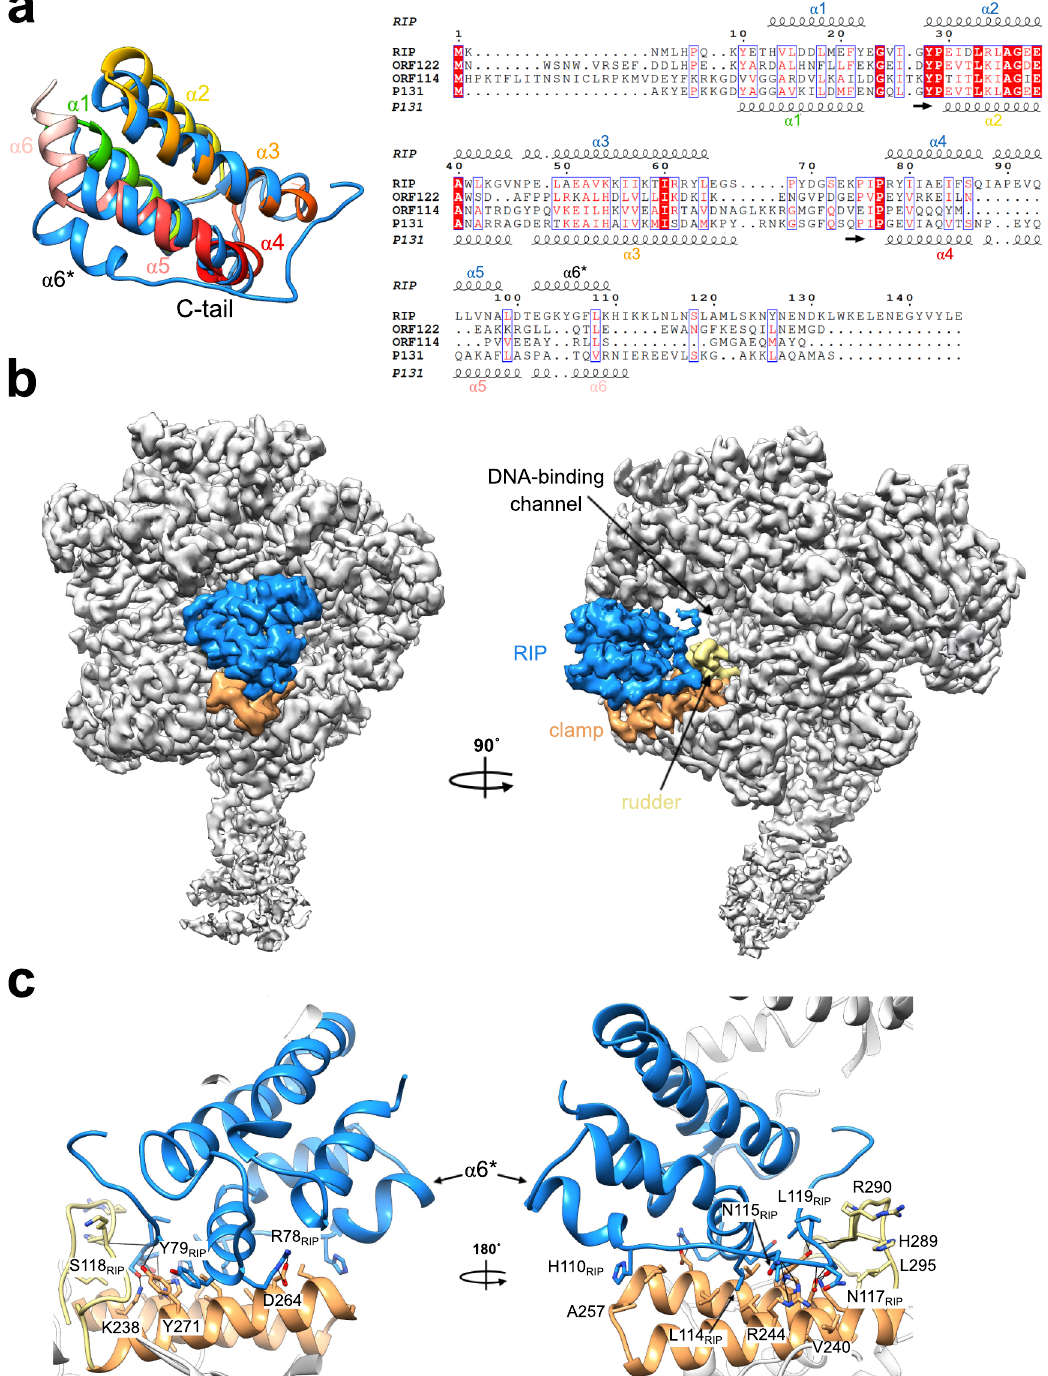
Fig. 2 RIP forms a plug on top of the DNA binding channel of RNAP. a Structure superimposition of RIP and its viral relative ORF131/P131 (pdb code 3faj). RIP is shown in blue and ORF131/P131 in a gradient of colours from the N-terminus in green to C-terminus in light pink with the helix numbering indicated. The orientation of the RIP α 6 helix (indicated with an asterisk) diverges from P131. The corresponding multiple sequence alignment with viral proteins closely related to RIP was performed in PROMALS3D. They include SMV-1 ORF122 and ORF114, as well as the ATV P131 (ORF131). The secondary structure annotation generated by Espript3 for RIP and P131 are shown, respectively, above and below the sequence alignment. b The cryo-EM map of the Saci RNAP-ATV RIP complex reveals that RIP forms a plug in the DNA binding channel. RIP is coloured in blue, the RNAP clamp and rudder motifs in orange and yellow, respectively. c Enlarged view highlighting selected residues of RIP, RNAP clamp head and rudder motifs that are involved in the interaction shown in stick representation. The detailed RIP-RNAP interfaces analysis is illustrated in Supplementary Fig.